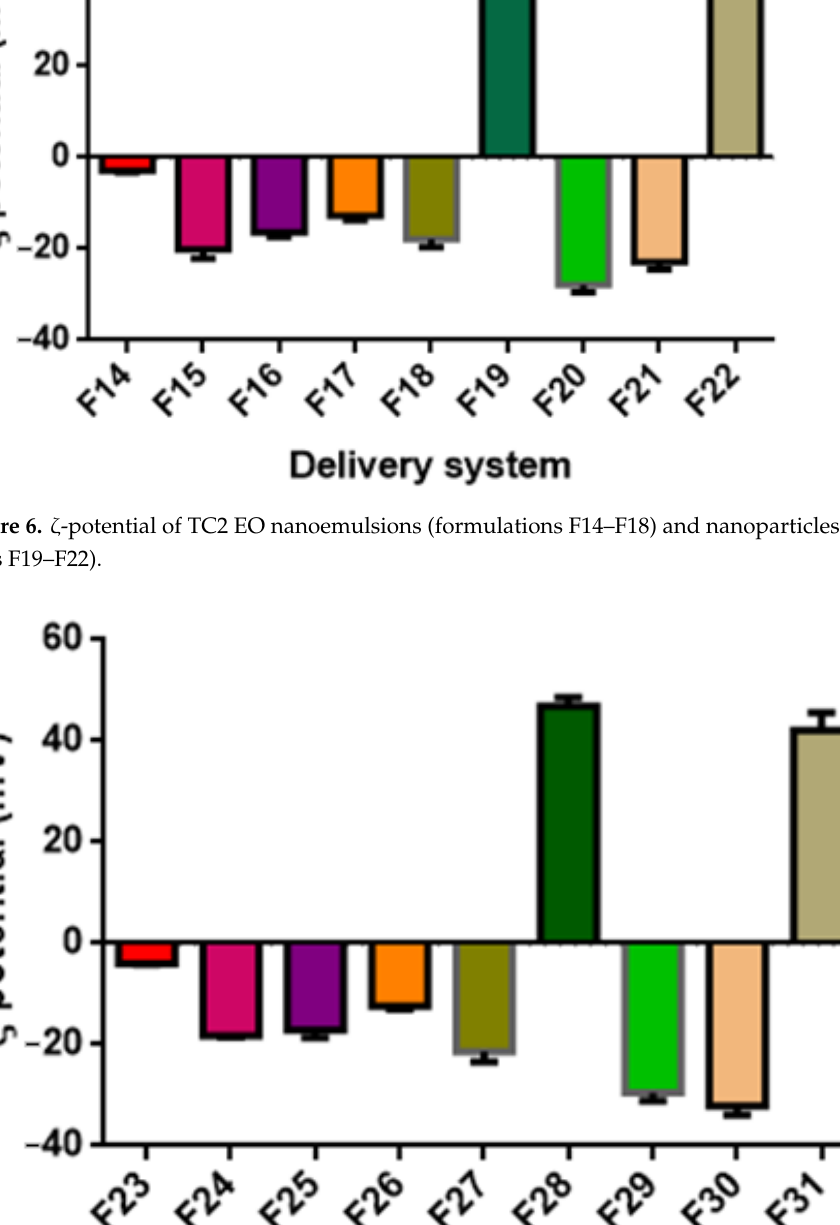
Figure 7. ζ -potential of TA EO nanoemulsions (formulations F23–F27) and nanoparticles (formula- tions F28–F31).